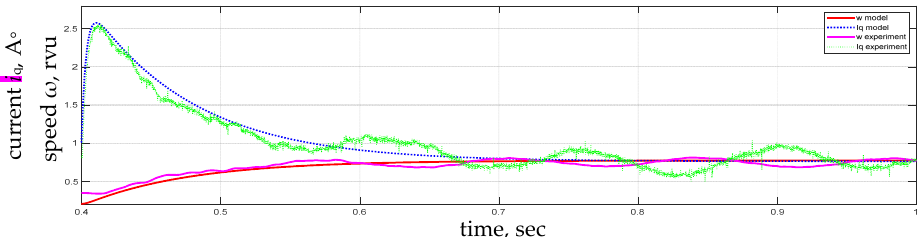
the q axis are shown in Figure 9.